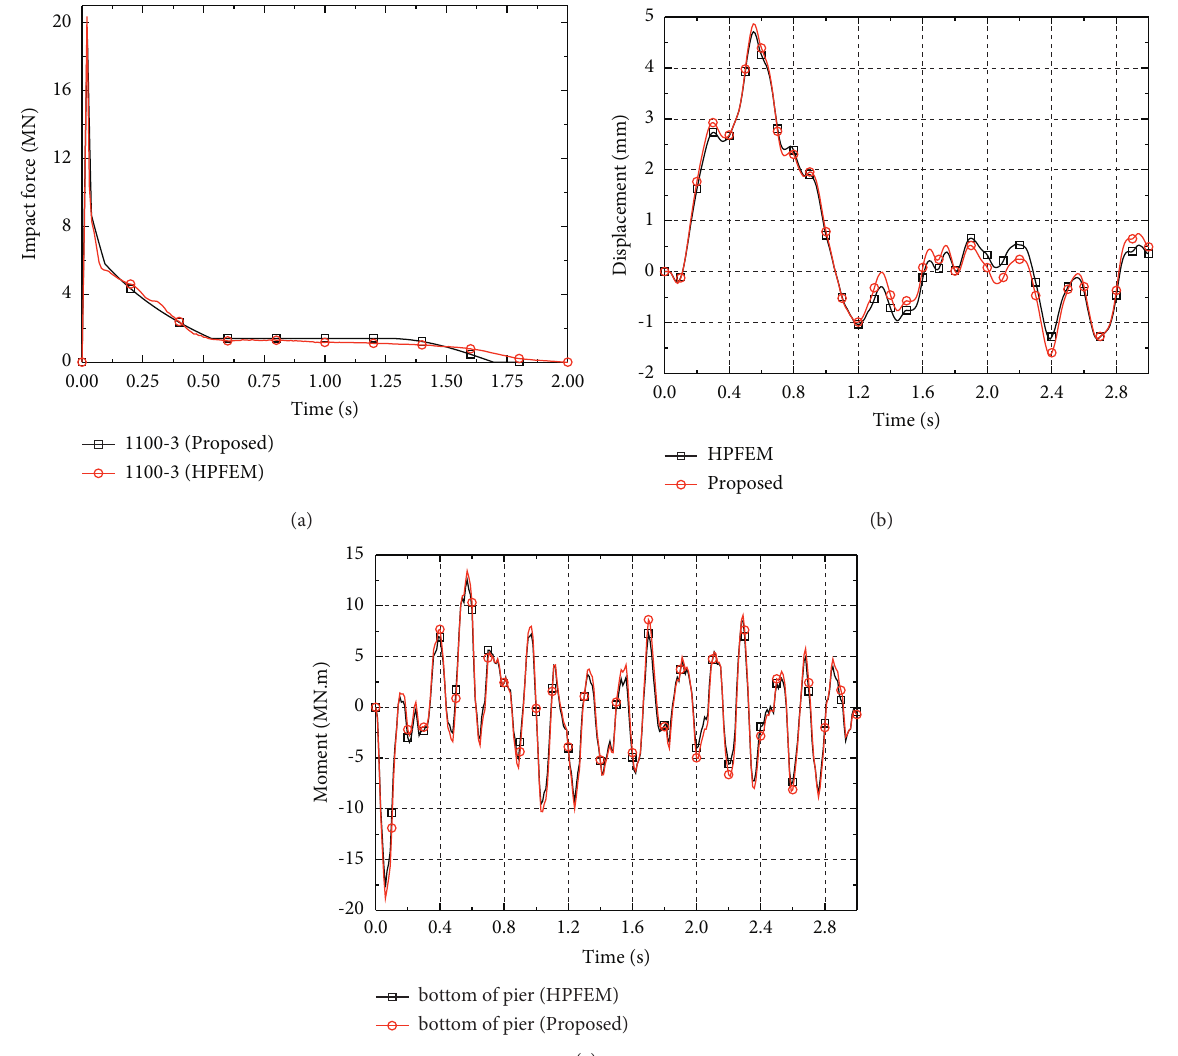
Figure 19: Results of a simulation of a collision by a 1100-ton barge at the impact velocity of 3m/s. (a) Time history of impact force (1100t +3m/s). (b) Time history of displacement of pier top (1100t+3 m/s). (c) Time history of moment of pier bottom (1100t+3 m/s).